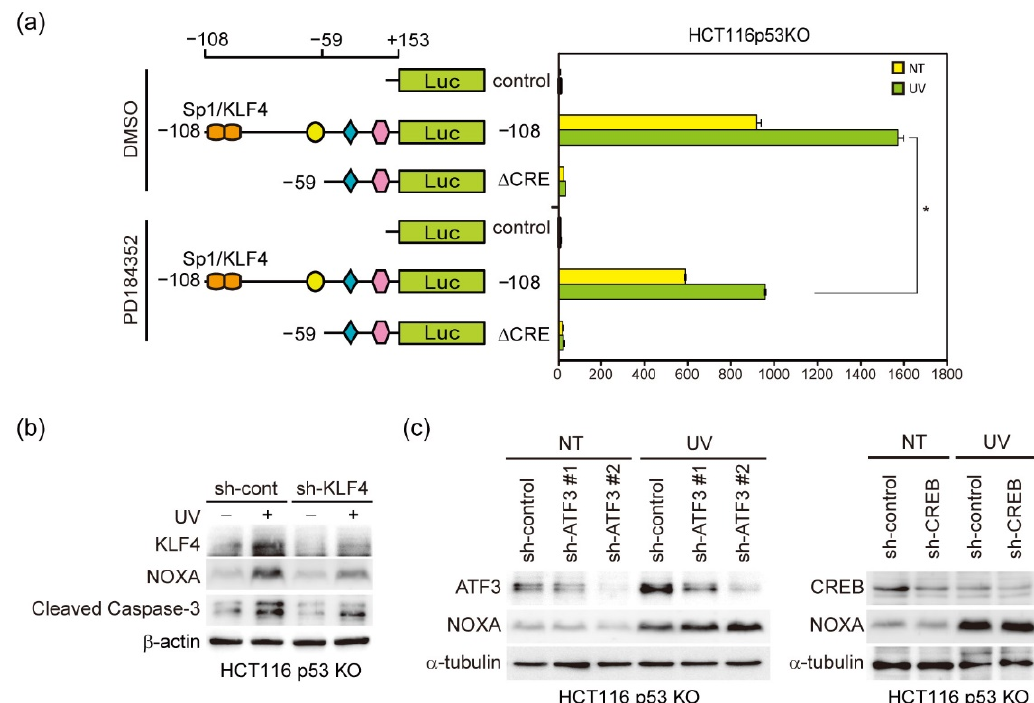
Figure 4. KLF4 is responsible for the p53-independent induction of NOXA expression by UV light irradiation. ( a ) After 24 h of transfection of reporter constructs, HCT116 p53 KO cells were treated with PD184352 (5 µ M) prior to UV light irradiation. Cells were irradiated with (green bars) or without (yellow bars) UV light for 24 h, after which Firefly- and Renilla-dependent luciferase activities were determined. Firefly-dependent luciferase activity was normalized by the respective Renilla signal. Data are shown as the mean ± S.D. ( n = 3). Each value represents an average from three independent experiments. ( b , c ) HCT116 p53 KO cells stably expressing shRNA-targeting KLF4 (sh-KLF4), ATF3 (sh-ATF3 #1, sh-ATF3 #2), CREB (sh-CREB) or sh-control were irradiated with UV light (100 J/m 2 ). After 24 h of irradiation, 20 µ g of total cell lysates was subjected to immunoblot analysis with the indicated antibodies. Quantitative analysis of immunoblot results is shown in Supplementary Figure S3a,b.